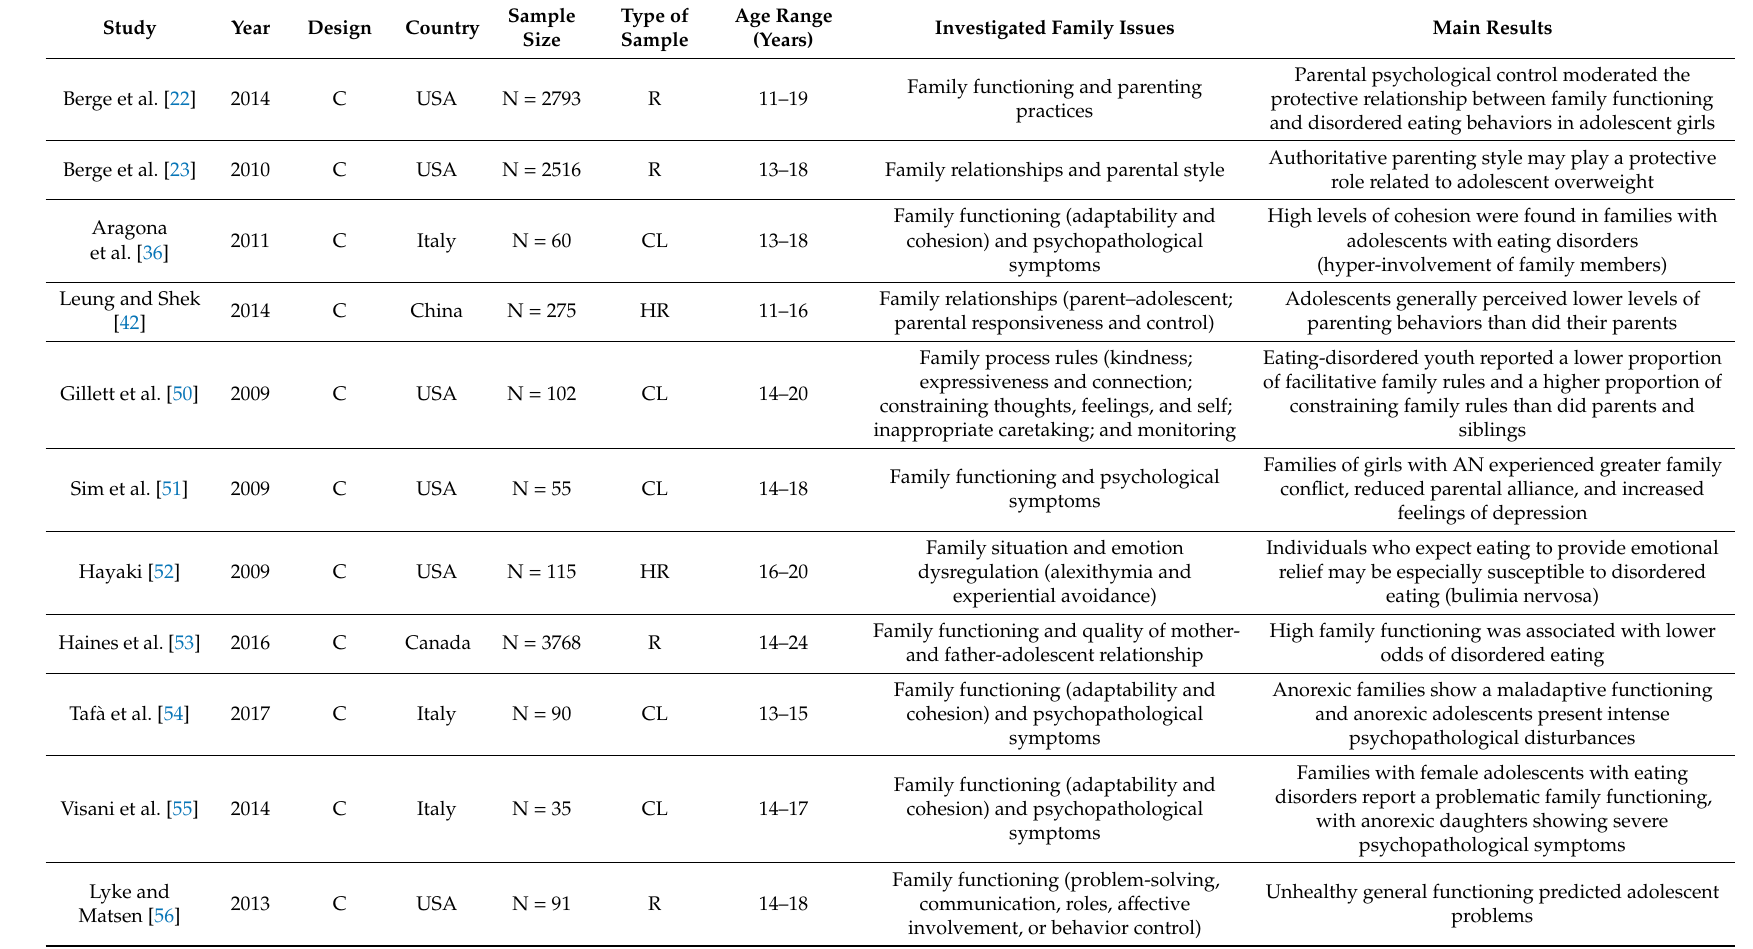
Table 1. Characteristics of included